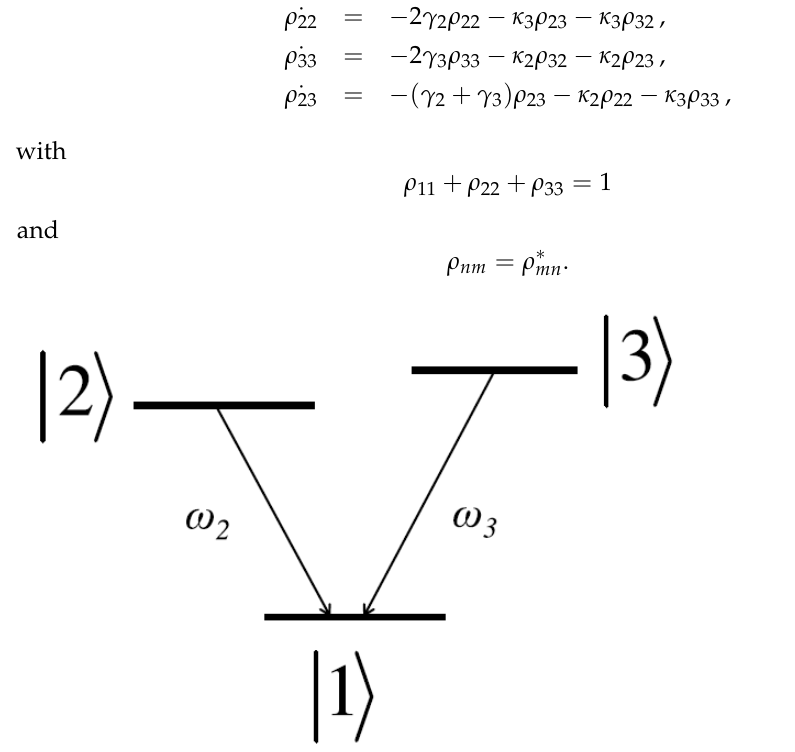
Figure 1. A V-type three-level quantum